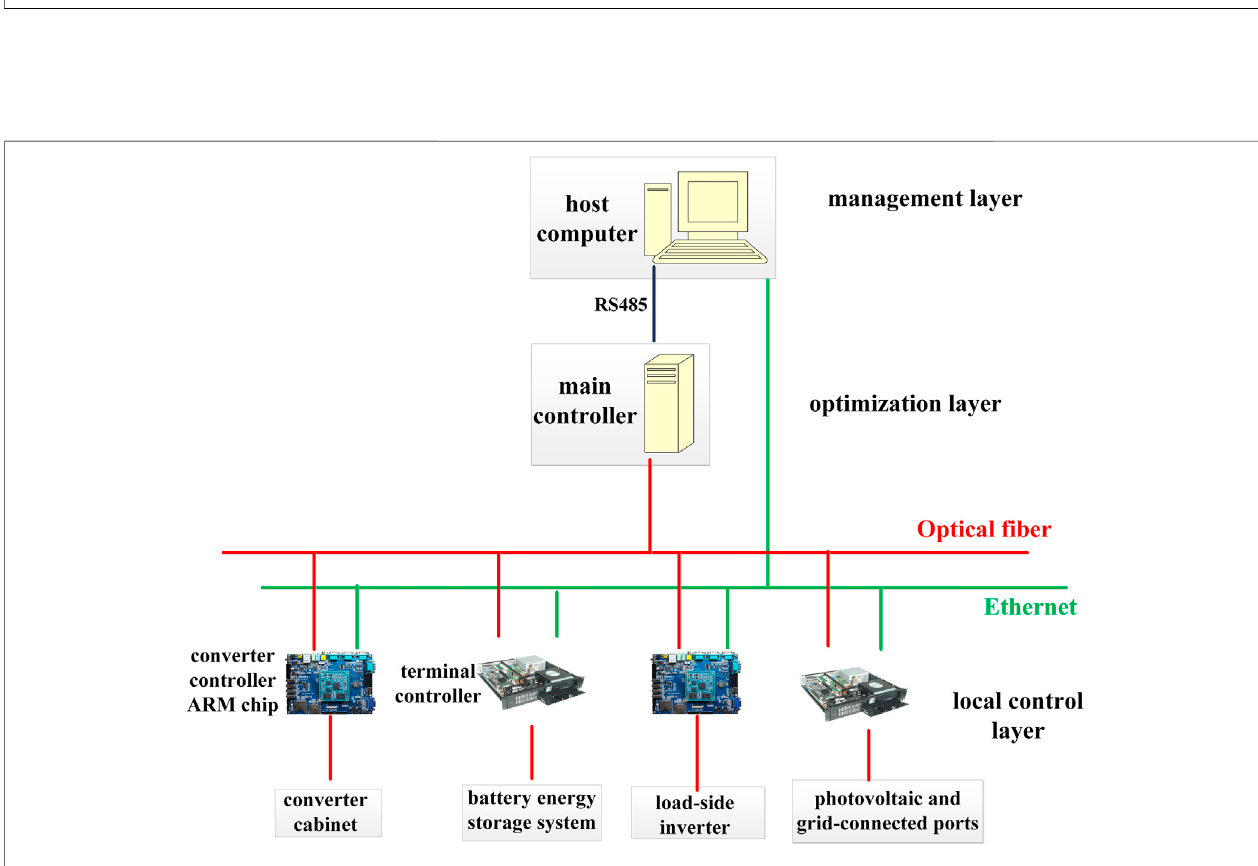
FIGURE 8 | Control structure of the DC microgrid prototype.